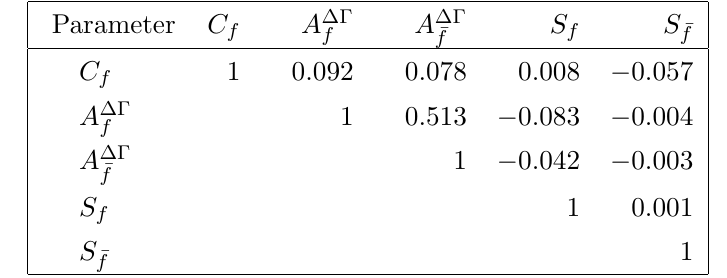
Table 4 . Statistical correlation matrix of the CP parameters. Other (cid:12)t parameters have negligible correlations with the CP